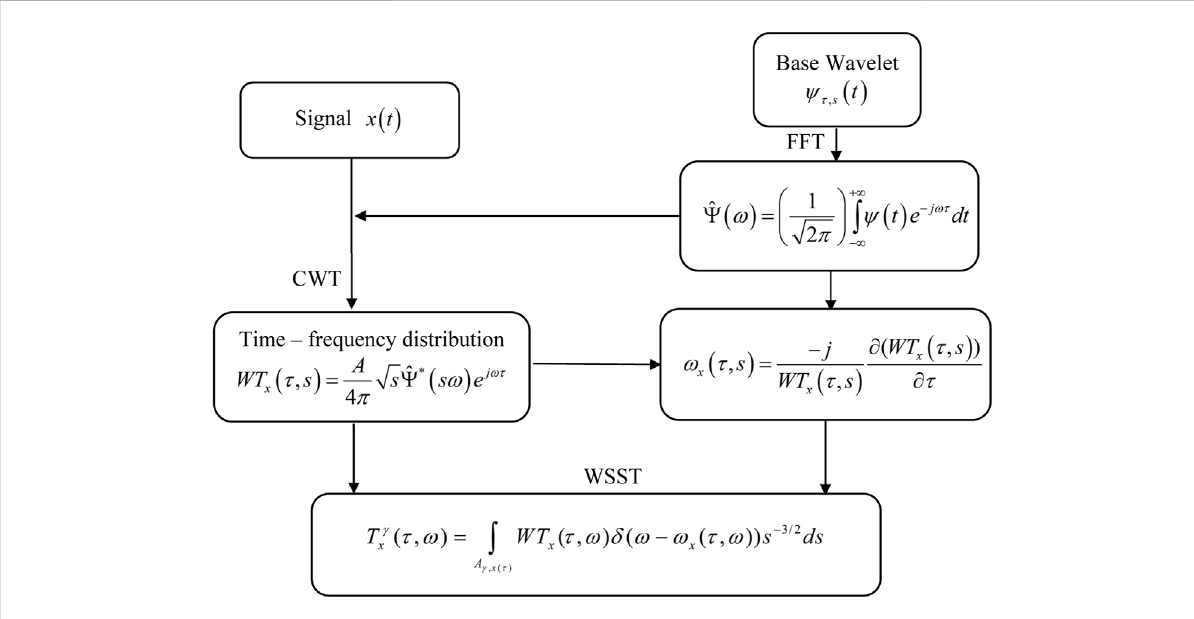
FIGURE 4 Flowchart of the wavelet synchrosqueezing transform.